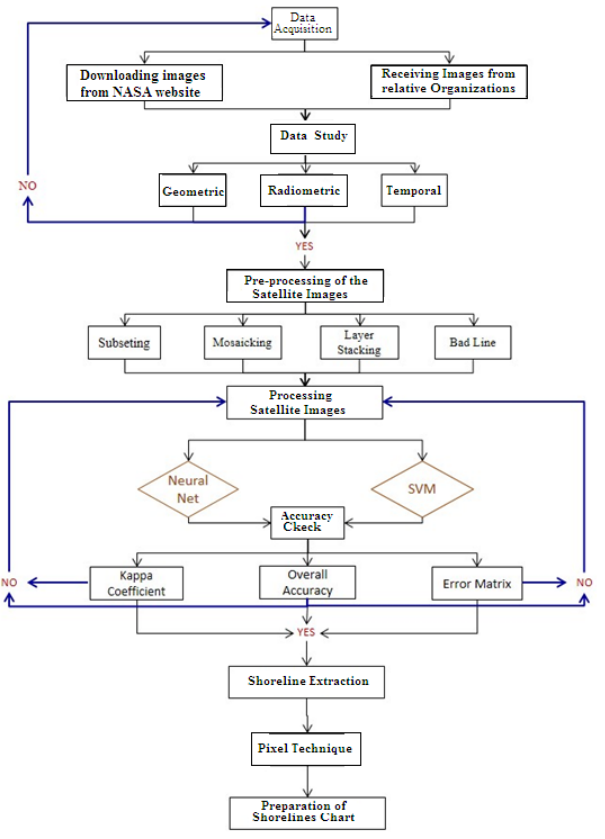
Figure 5: The algorithm for extracting the shoreline out of the process